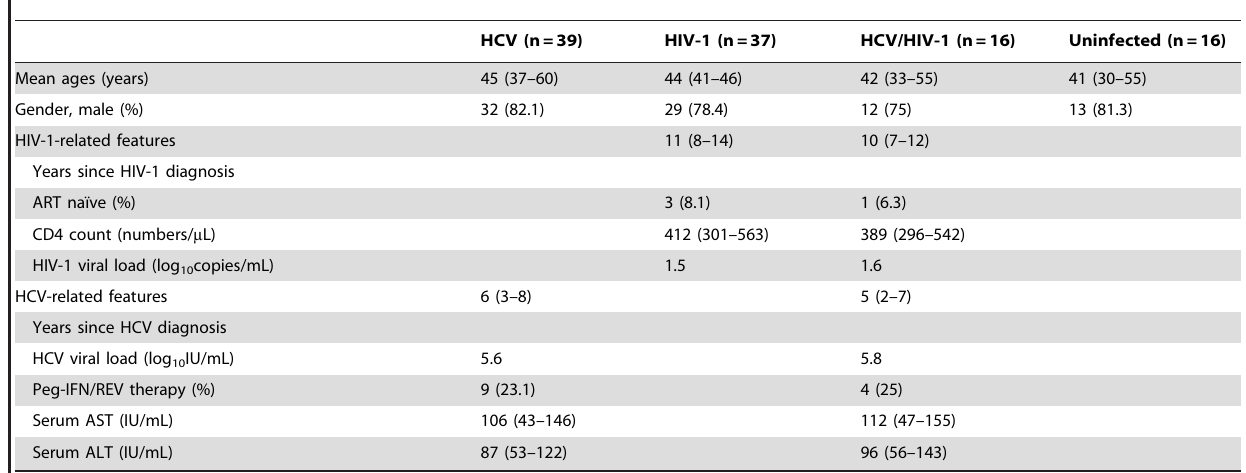
Table 2. Demographic and clinical characteristics of the cohort 2